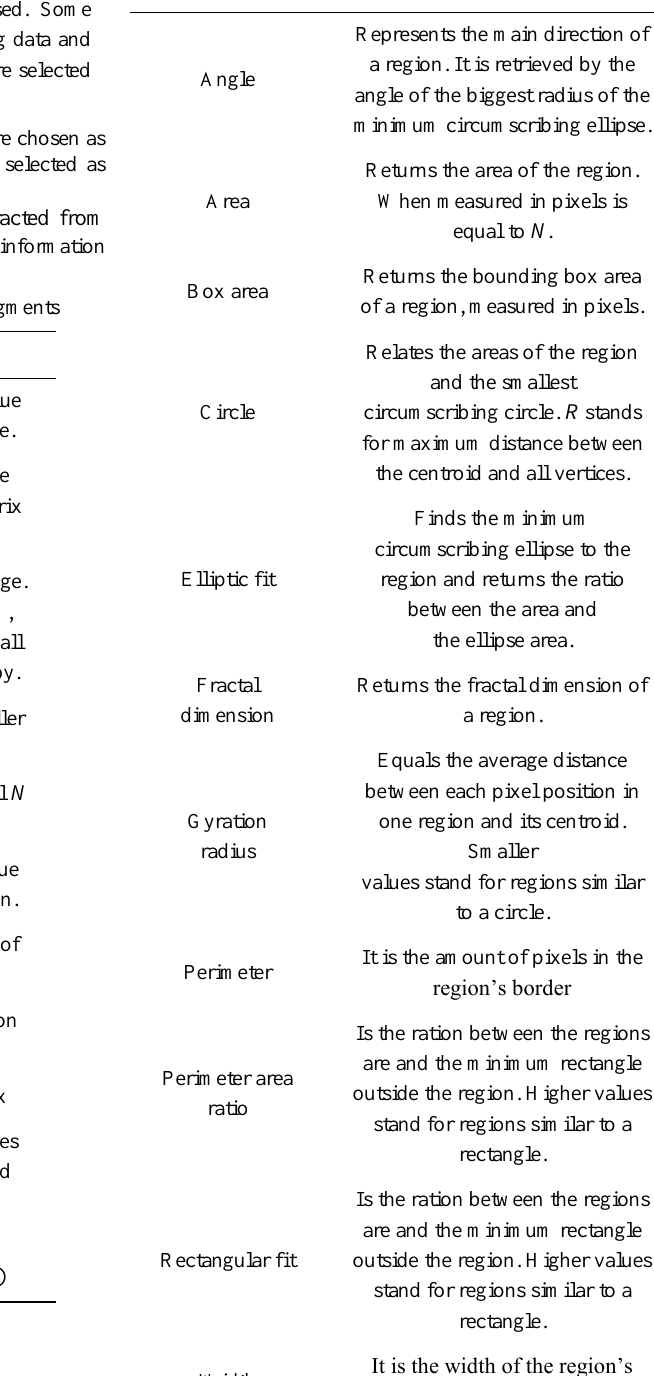
Table 2. Spatial features extracted from the